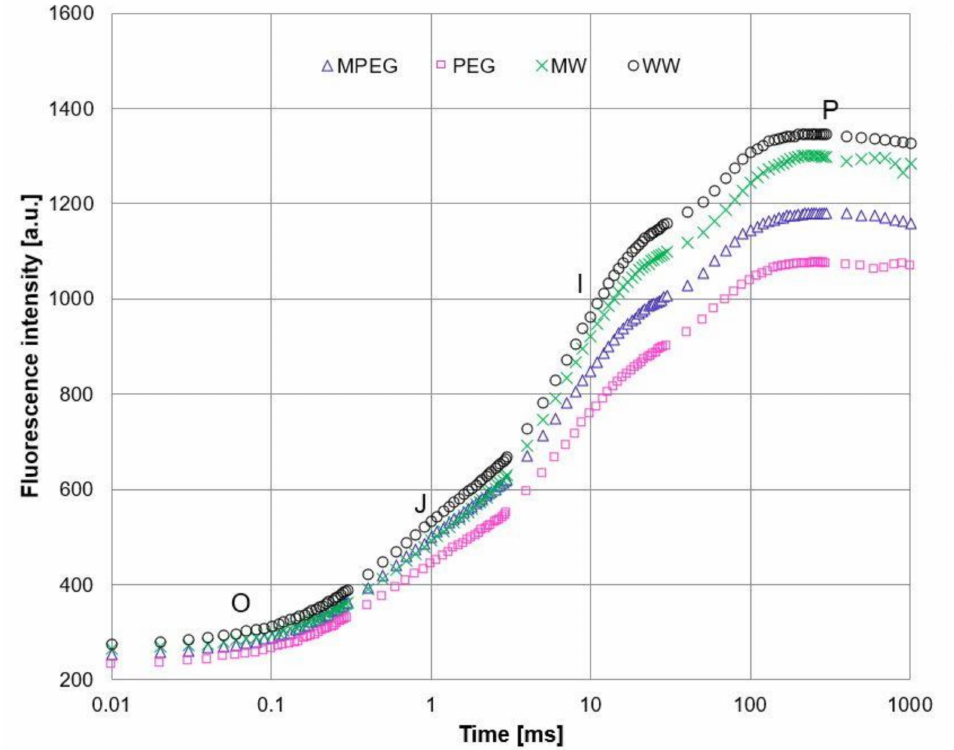
Figure 4. Fast Chlorophyll-a fluorescence kinetics OJIP of the dark-adapted leaves of the oat plants. Transient polyphasic curves of each line represent the means of 15 measurements (5 measurements per plant taken from 3 di ff erent plants). WW, well-watered; PEG, PEG-treated oat plants; MW, melatonin-treated, well-watered oat plants; MPEG, Melatonin-treated oat plants subjected to PEG stress. The relative fluorescence between the steps O and K (20 and 300 s, respectively = W OK = (F t − F O ) / (F K − F O )) and O and J (20 s and 2 ms, respectively = W OJ = (F t − F O ) / (F J − F O )) were normalized and are shown as the kinetic di ff erence ∆ W OK = W OK(treatment) − W OK(control) and ∆ W OJ = W OJ(treatment) ff erent kinetics ∆ W ∆ W − W OJ(control) , respectively. The di OK and OJ enable the visibility of the L- and K-band, respectively (Figures 5 and